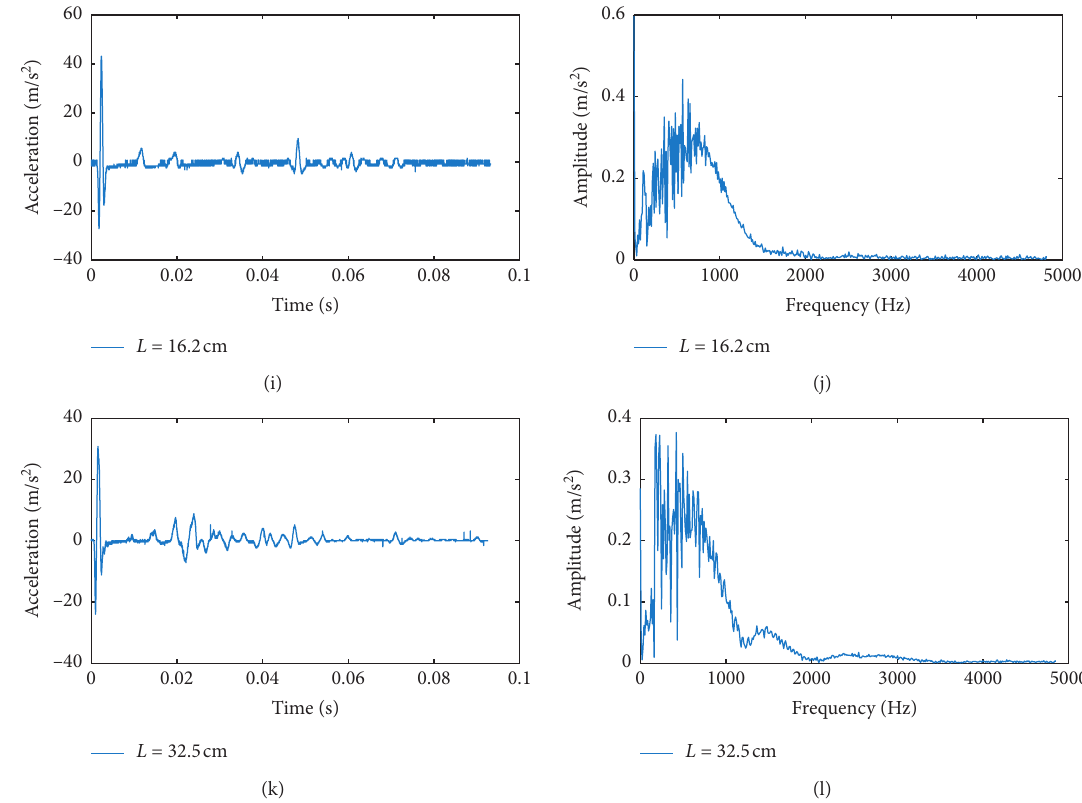
Figure 12: (a, c, e, g, i, k) Time-domain waveforms and (b, d, f, h, j, l) frequency spectra for different Teflon